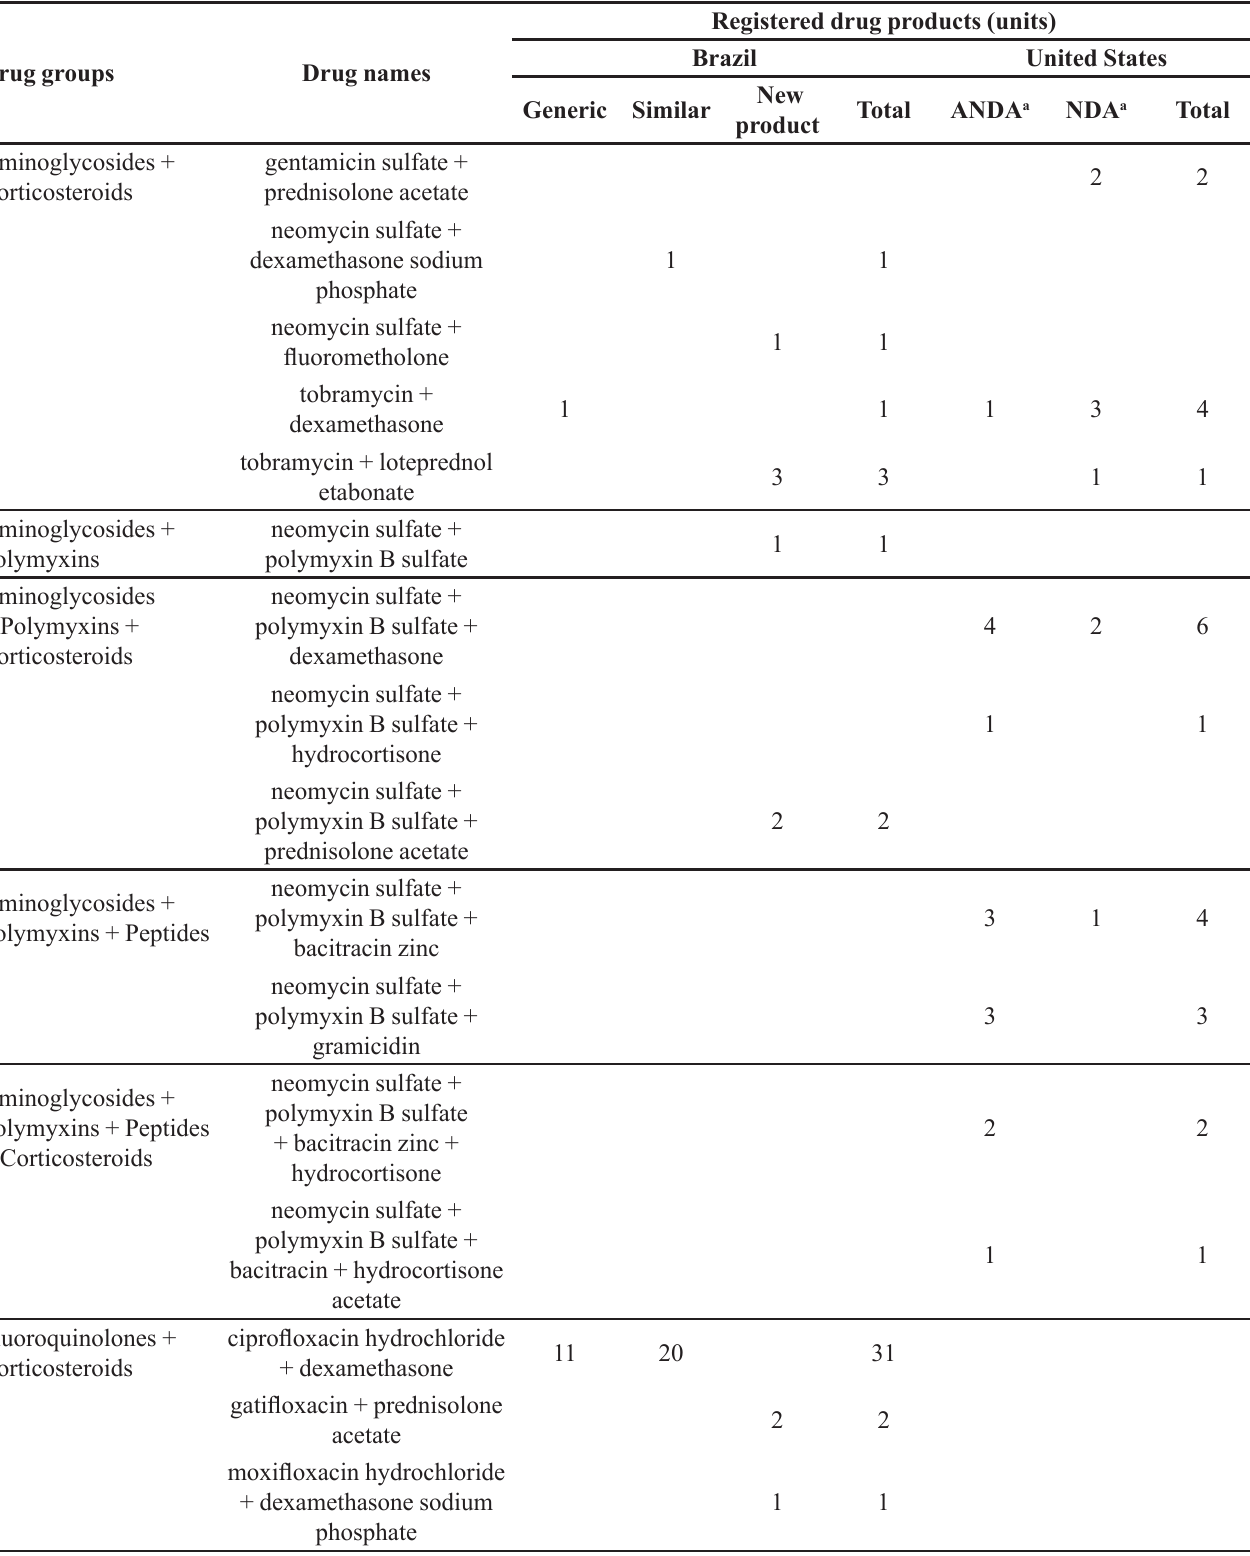
TABLE II - Comparison of drug substances groups registered as combined ophthalmic products in Brazil and in the United States